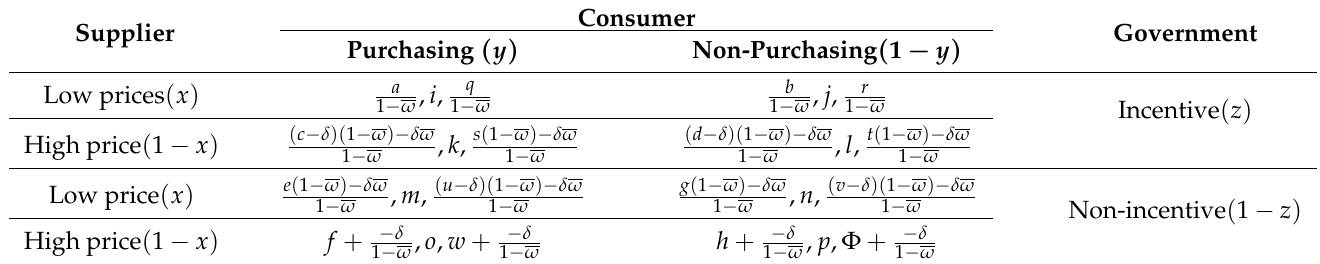
Table 2. Tripartite repeated game